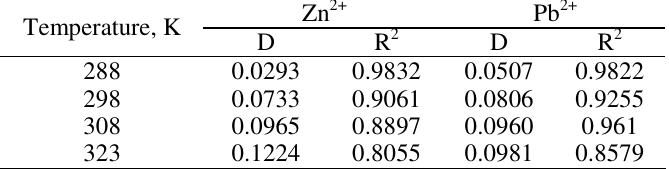
Table 5. Values of distribution coefficients for the adsorption of Zn 2+ and Pb 2+ onto human hair at different temperature